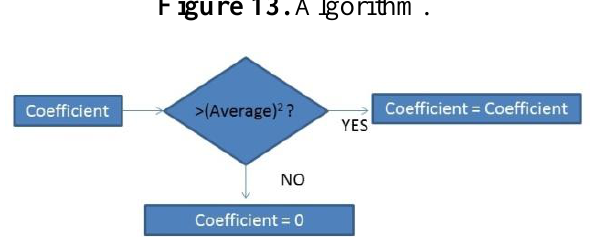
Figure 13. Algorithm.